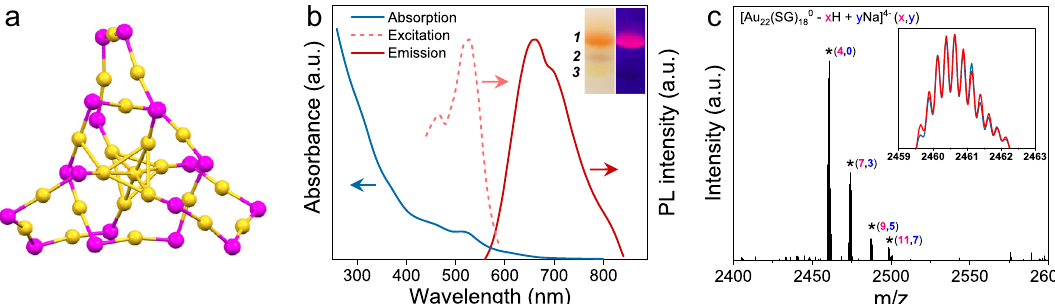
Fig. 1 Characterization of Au 22 (SG) 18 nanoclusters. a The Au-S framework of Au 22 (SR) 18 nanoclusters (NCs) (drawn according to the reported structure 43 ). The yellow spheres represent Au atoms, and the purple spheres represent S atoms. b UV-vis absorption, photoexcitation, and photoemission spectra of the puri fi ed Au 22 (SG) 18 NCs. Inset: Digital photos of the PAGE gels of gold NCs under visible (left) and UV (right) light. Bands 1 – 3 correspond to Au 22 (SG) 18 , Au 18 (SG) 14 , and Au 15 (SG) 13 , respectively. a.u. arbitrary units. c Electrospray ionization (ESI) mass spectrum of Au 22 (SG) 18 NCs. Inset shows the experimental (blue line) and simulated (red line) isotope patterns of [Au 22 (SG) 18 0 – 4H] 4 − . a.u. arbitrary